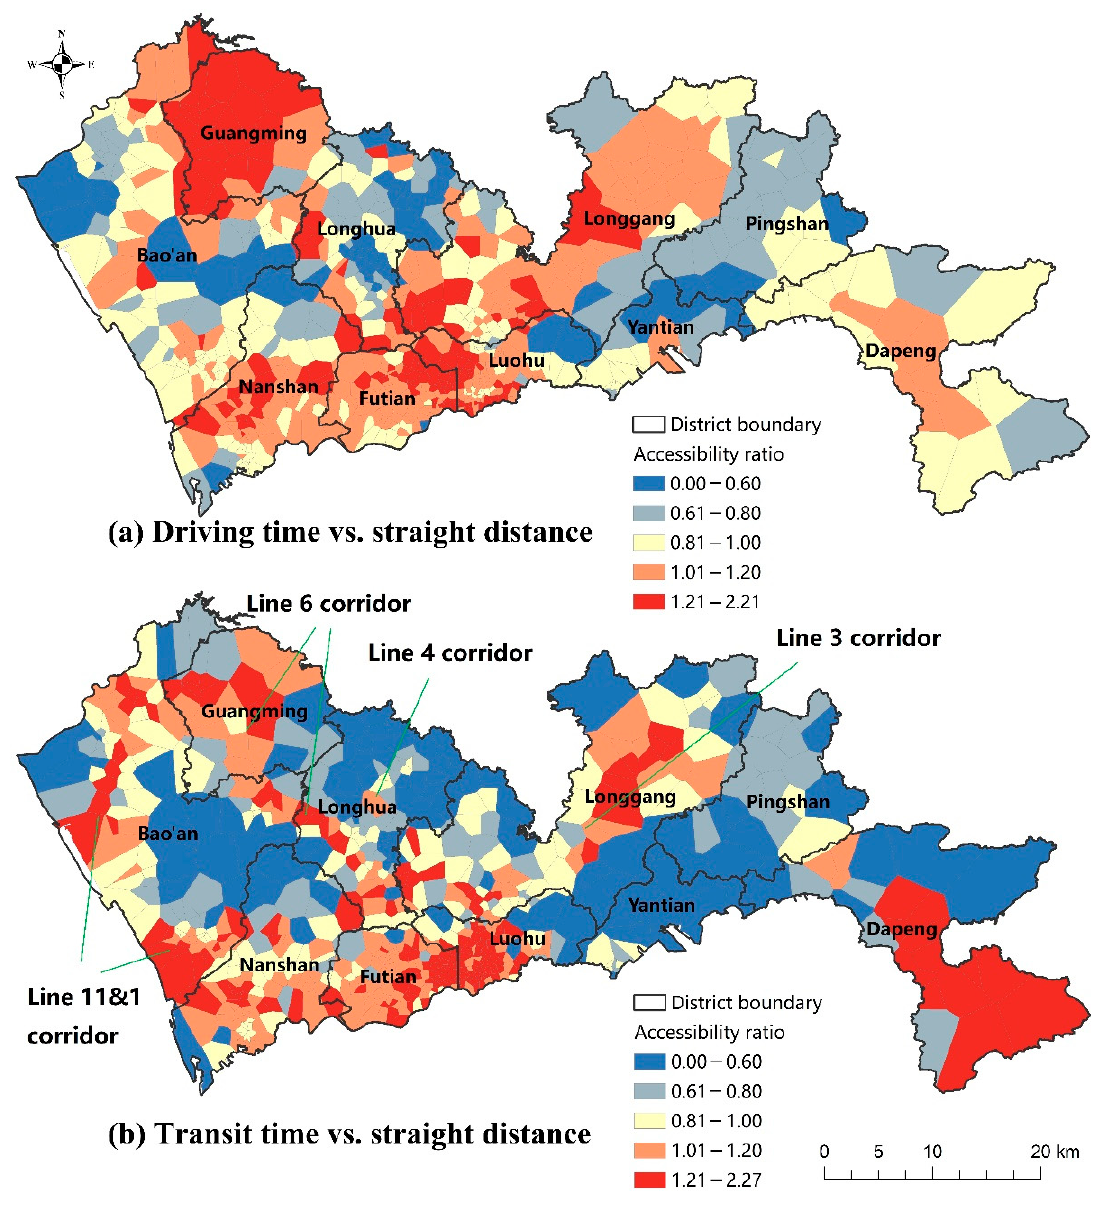
Figure 6. The distribution of the ratios of accessibility by various distance measures.